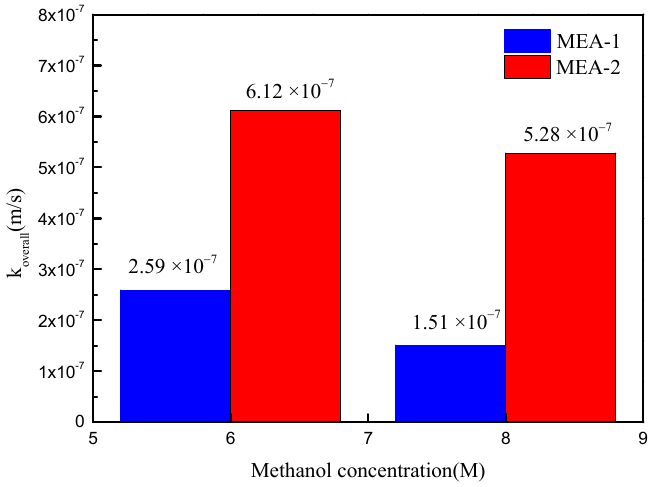
Figure 8. The overall mass transfer coefficient of different inlet methanol concentrations.